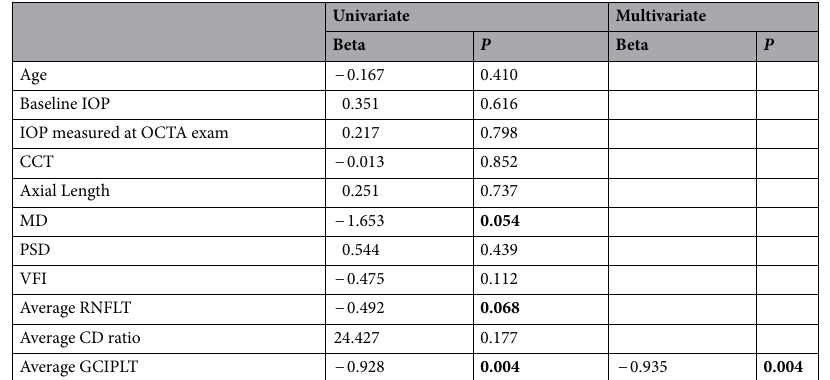
Table 5. Linear regression analysis to determine the correlation between variables and width of superficial vascular defect in all eyes (N, 72). SVD superficial vessel defect, DVD deep vessel defect, IOP intraocular pressure, OCTA optical coherence tomography angiography, CCT central corneal thickness, MD mean deviation, PSD pattern standard deviation, VFI visual function index, RNFLT retinal nerve fiber layer thickness, CD cup to disc, GCIPLT ganglion cell inner plexiform layer thickness. Only variables with a P value < 0.10 in the univariate analysis were included in the multivariate model. Bold font indicates significant P values ( P < 0.05).